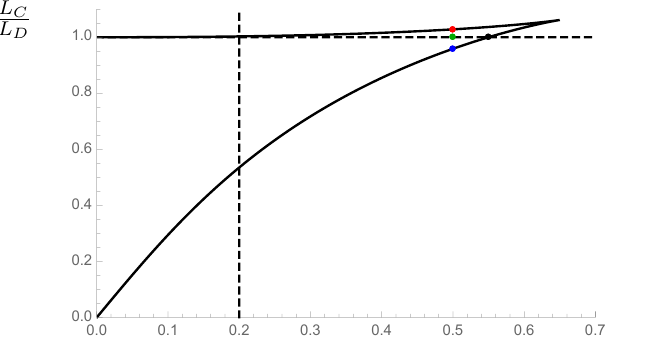
Figure 2 . Ratio of the connected geodesic length to the disconnected geodesic length for J 1 = 1 = 5 as a function of J 2 . The red, green and blue dots correspond to the curves plotted in (cid:12)gure 1 for J 2 = 1 = 2 and the black dot marks the critical value of J 2 for this J 1 . The region to the left of the vertical dashed line is unphysical since J 2 < J 1